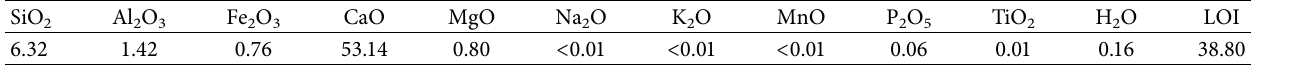
Table 4: Chemical composition of waste paper pulp ash.